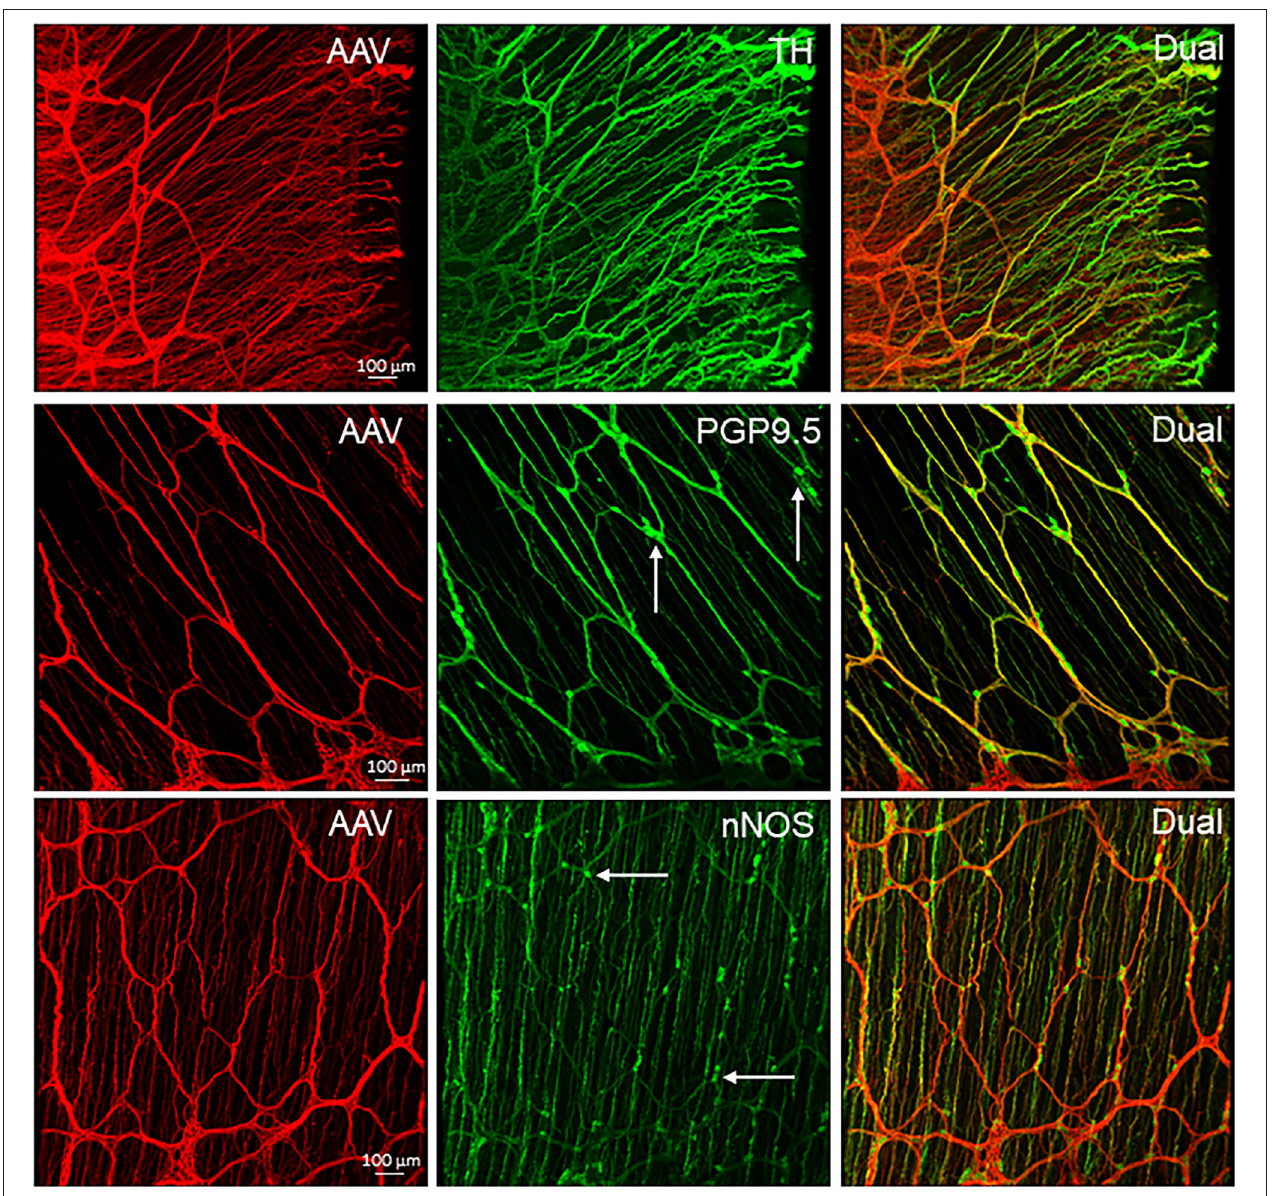
FIGURE 11 | PHP.S-tdTf transduced nerve fibers in the margins of mouse proximal colon combined with immunofluorescent labeling. PHP.S-tdTf (1 x 10 12 GC/mouse) was retro-orbitally injected 3 weeks before. Upper row : the mesenteric margin enriched by nerve fibers, and many dual-labeled by PHP.S-tdTf and TH. Middle row and lower row : the antimesenteric margin consisted of small circumferential nerve bundles and scattered neurons immunostained by PGP9.5 or nNOS (arrows). Scales 100 µ m for each